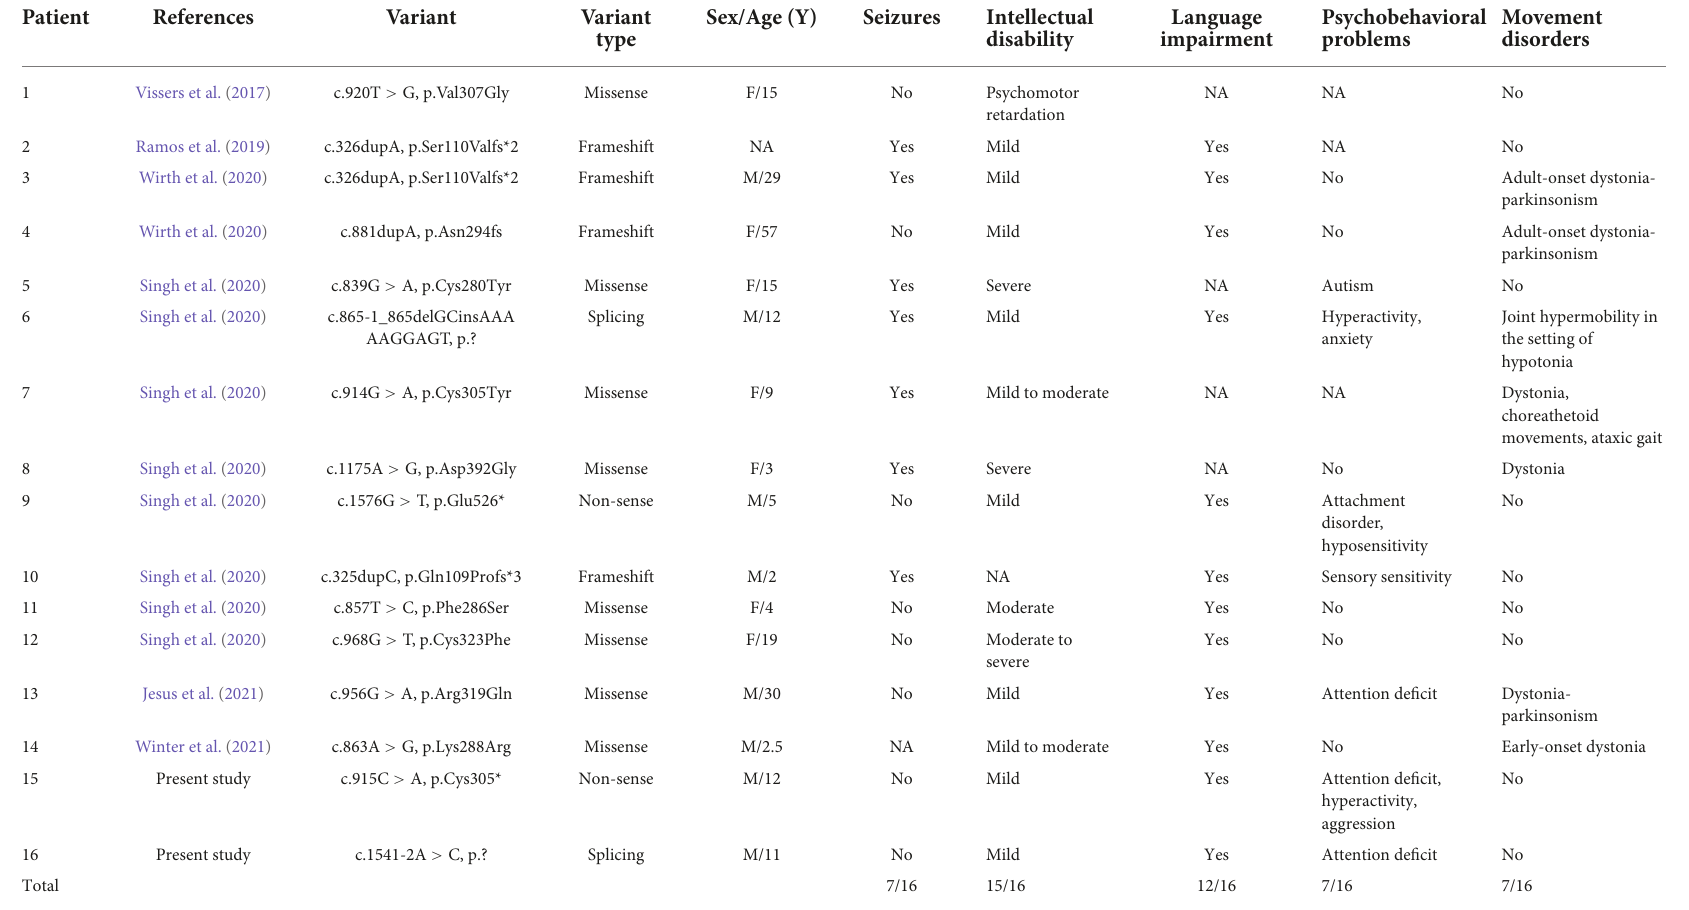
TABLE 1 Genetic and clinical features of patients with NR4A2 LP/P